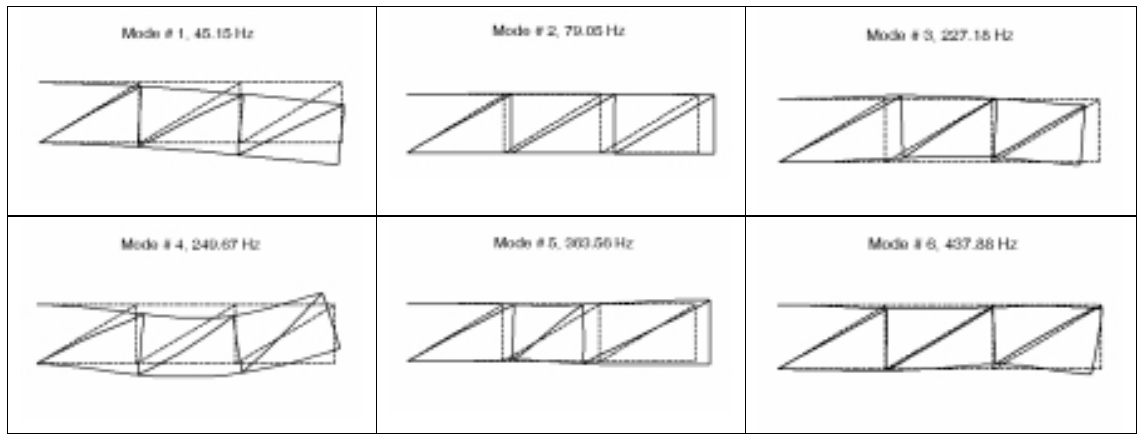
Fig. 5. Eigenmodes of the system from Fig.